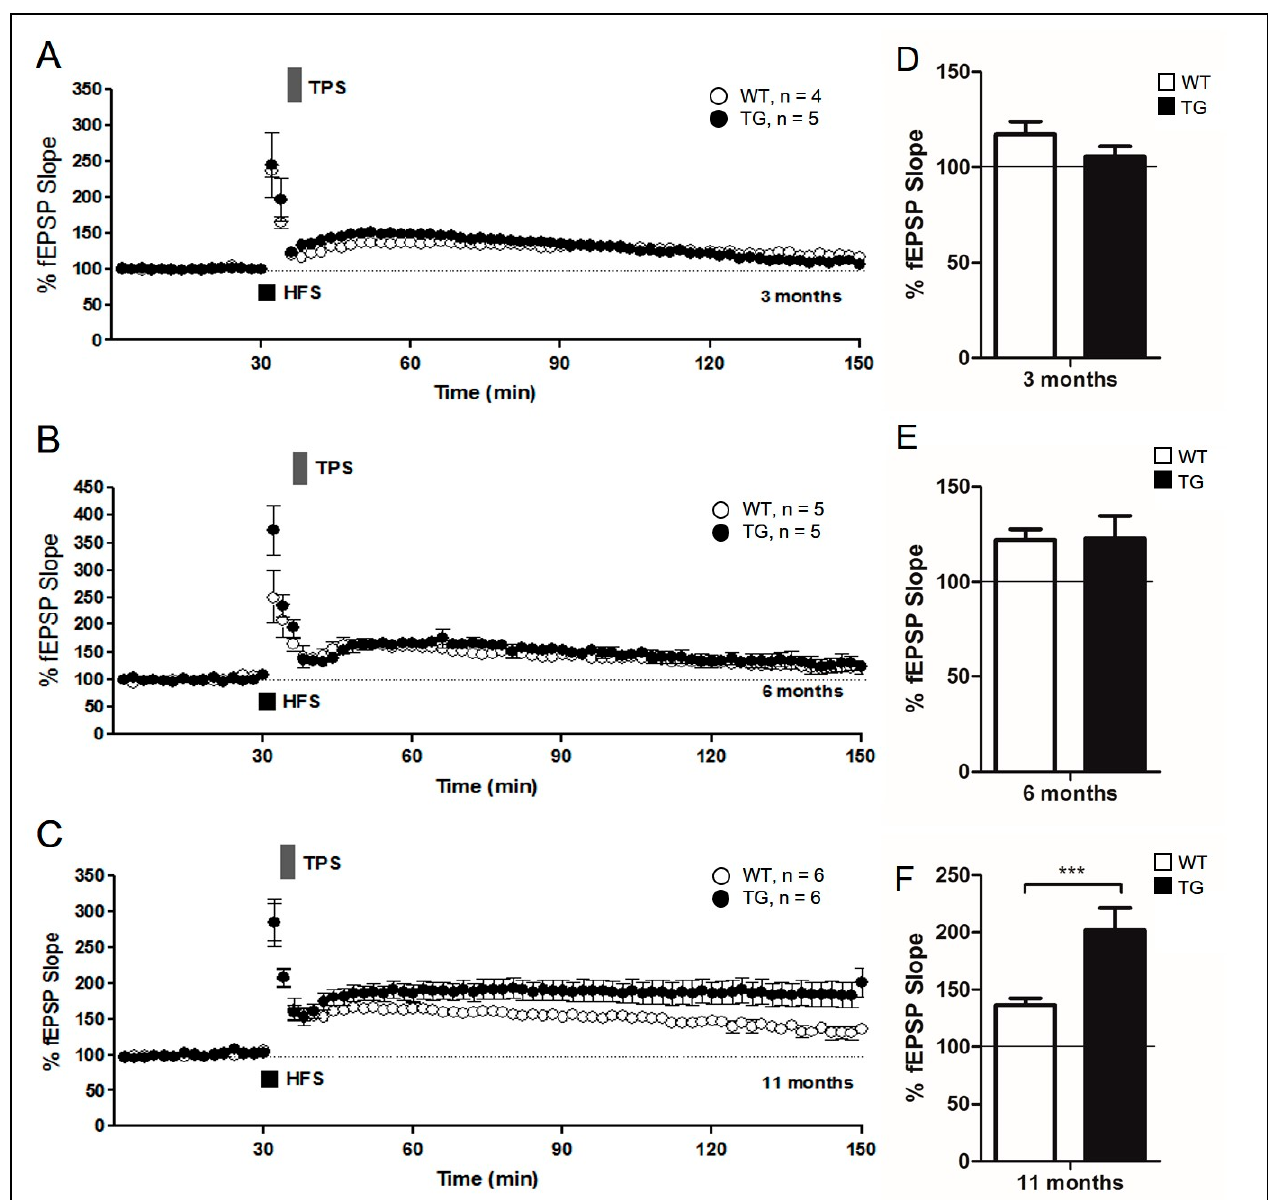
Figure 4. Evaluation of depotentiation -induced NRG1-ErbB signaling and theta-pulse stimulation (TPS)-induced impair- ment of depotentiation in aged 5xFAD mice. ( A – C ) Application of theta-pulse stimulation (TPS) (5 Hz for 1 min) 5 min after high-frequency stimulation (HFS) inverts LTP in WT and 5xFAD mice. ( D – F ) Summary of the results of the graph. Data are displayed as the mean ± SEM (***, p < 0.0001 compared with the indicated group using unpaired t -test). fEPSP, field excitatory postsynaptic potential; WT, wild-type; TG, transgenic.